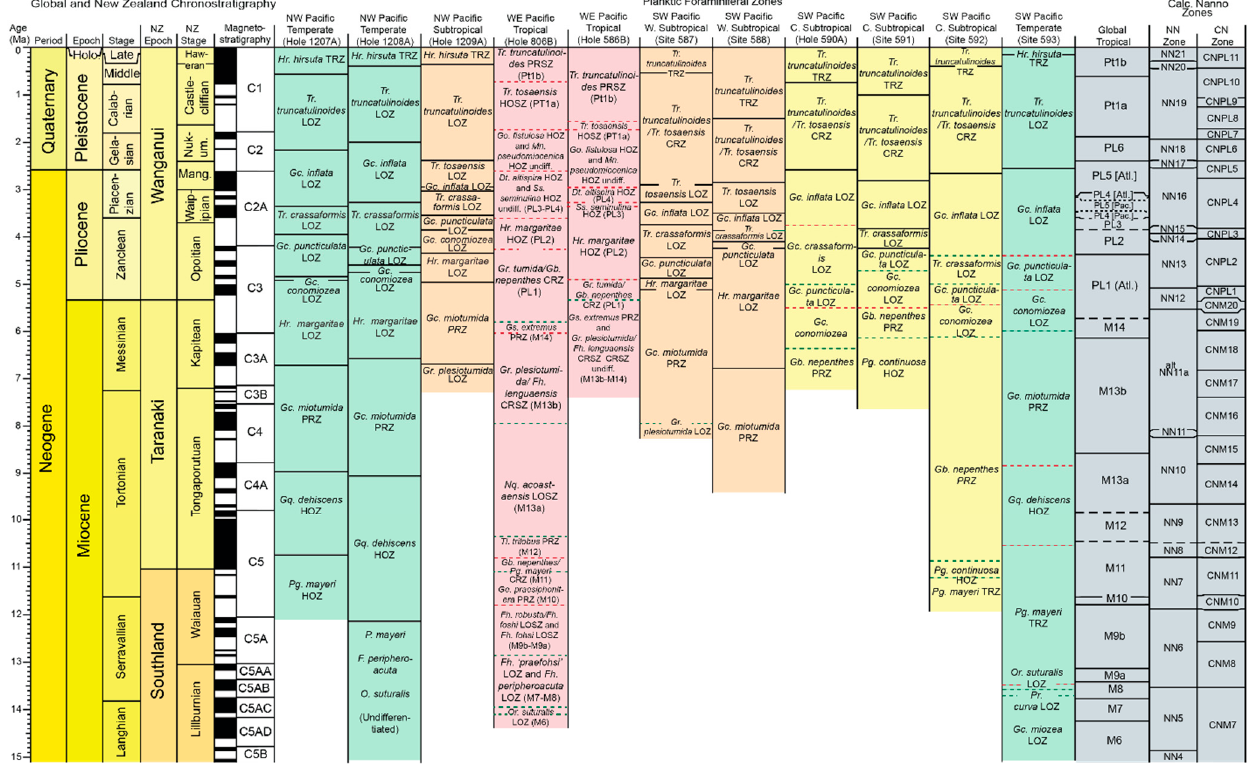
Figure 2. Global and New Zealand chronostratigraphy and magnetostratigraphy with major chrons and subchrons, plotted against the northwest, western equatorial, and southwest Pacific planktic foraminiferal biozones, and correlated with the global tropical planktic foraminiferal and calcareous nannofossil zones (in grey). Sites that utilize the tropical zonation (western equatorial Holes 806B and 586B) are in red, the warm subtropical (southwest Pacific Sites 587 and 588) and subtropical (northwest Pacific Hole 1209A) zonations are in orange, the cool subtropical (southwest Pacific Sites 590A, 591, and 592) zonations are in yellow, and the temperate (northwest Pacific Holes 1207A and 1208A, southwest Pacific Site 593) zonations are in green. Green dashed zone boundaries indicate a calcareous nannofossil or bolboform datum based on a species’ first occurrence, whereas red dashed zone boundaries indicate a datum based on a species’ last occurrence. Black solid zone boundaries indicate age constrained by magnetostratigraphy. Chronostratigraphy, tropical planktic foraminiferal, and calcareous nannofossil zones are from the GTS 2020 [68].